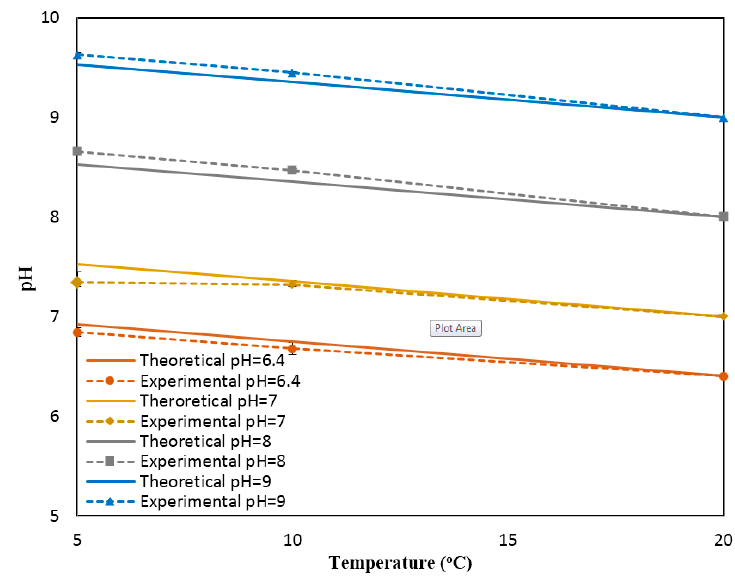
5.56.57.58.59.5